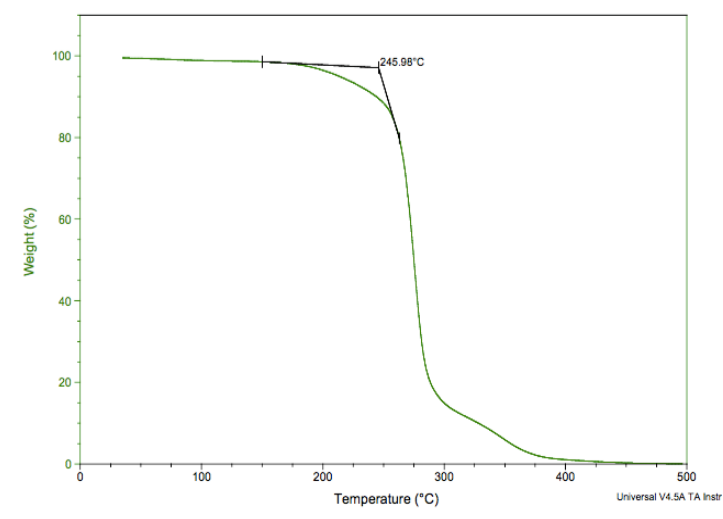
Figure 5. Thermal degradation ( T g ) of PHA polymer synthesized by P. putida LS46123 grown on octanoic acid. Table 3. Glass transition and melting temperatures of PHA polymers synthesized by P. putida LS46123 when grown on different fatty acids.